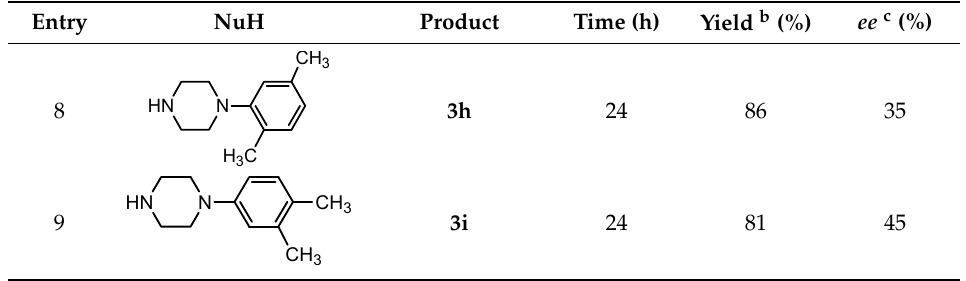
b = 10.034 (3), c = 17.732 (5), alpha = 90, beta = 90 (8), gamma = 90, T =296 K, space group. Orthorhombic, P 21 21 21, Z = 4. wR2 (reflections) = 0.1882 (3432). The Cambridge Crystallographic Data